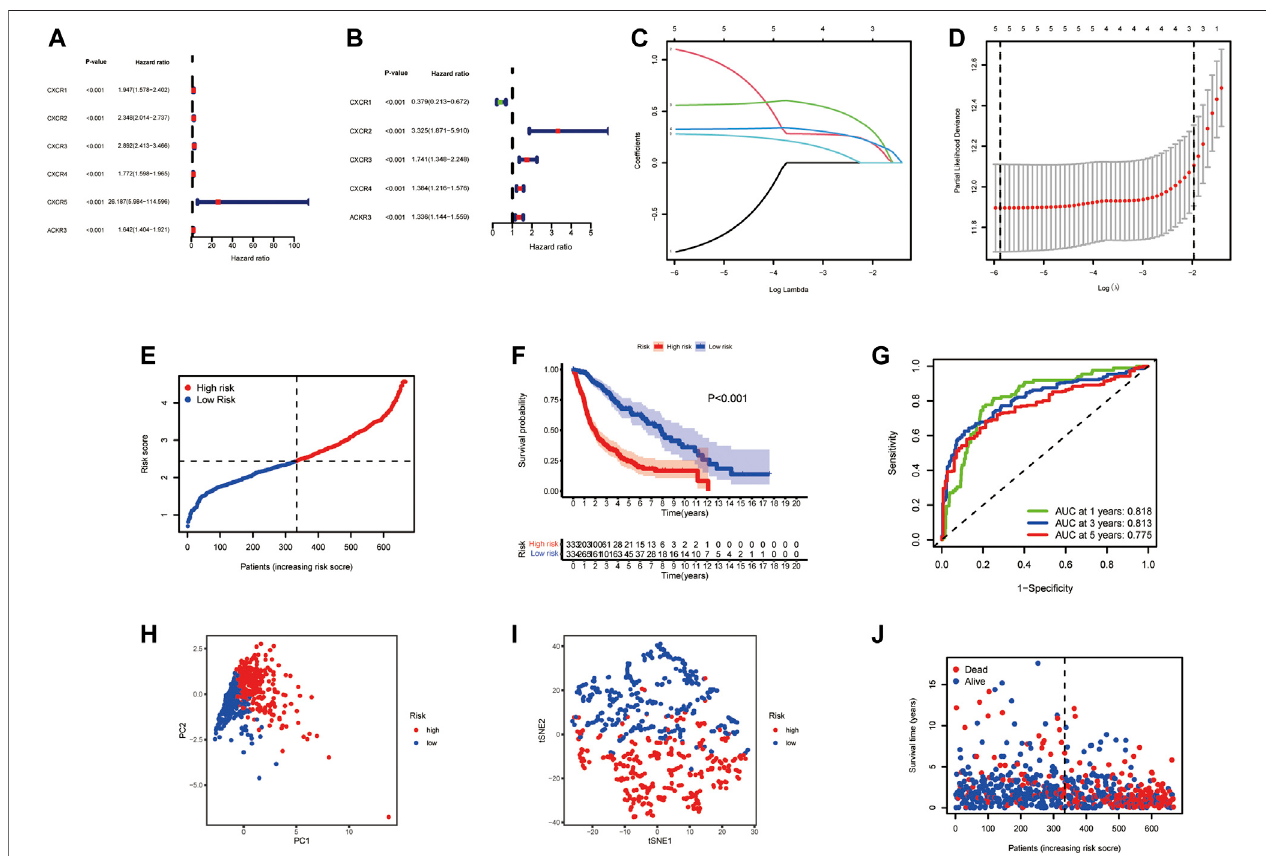
FIGURE 3 | Prognostic value of the risk signature model. Forest plot of prognostic CXCR genes based on univariate (A) and multivariable (B) Cox regression analysis. (C) Lasso coef fi cient pro fi les of the fi ve survival-related CXCRs. (D) Ten-fold cross-validation for tuning parameter selection in the Lasso model. (E) The distribution of CR-Score in the TCGA dataset. (F) Kaplan-Meier curve of OS in the high- (red) and low-(blue) risk groups. (G) ROC curves for the predictive model. (H) PCA plot of the TCGA cohort. (I) t-SNE plot for patients. (J) Distribution of the survival data and CR-Score.